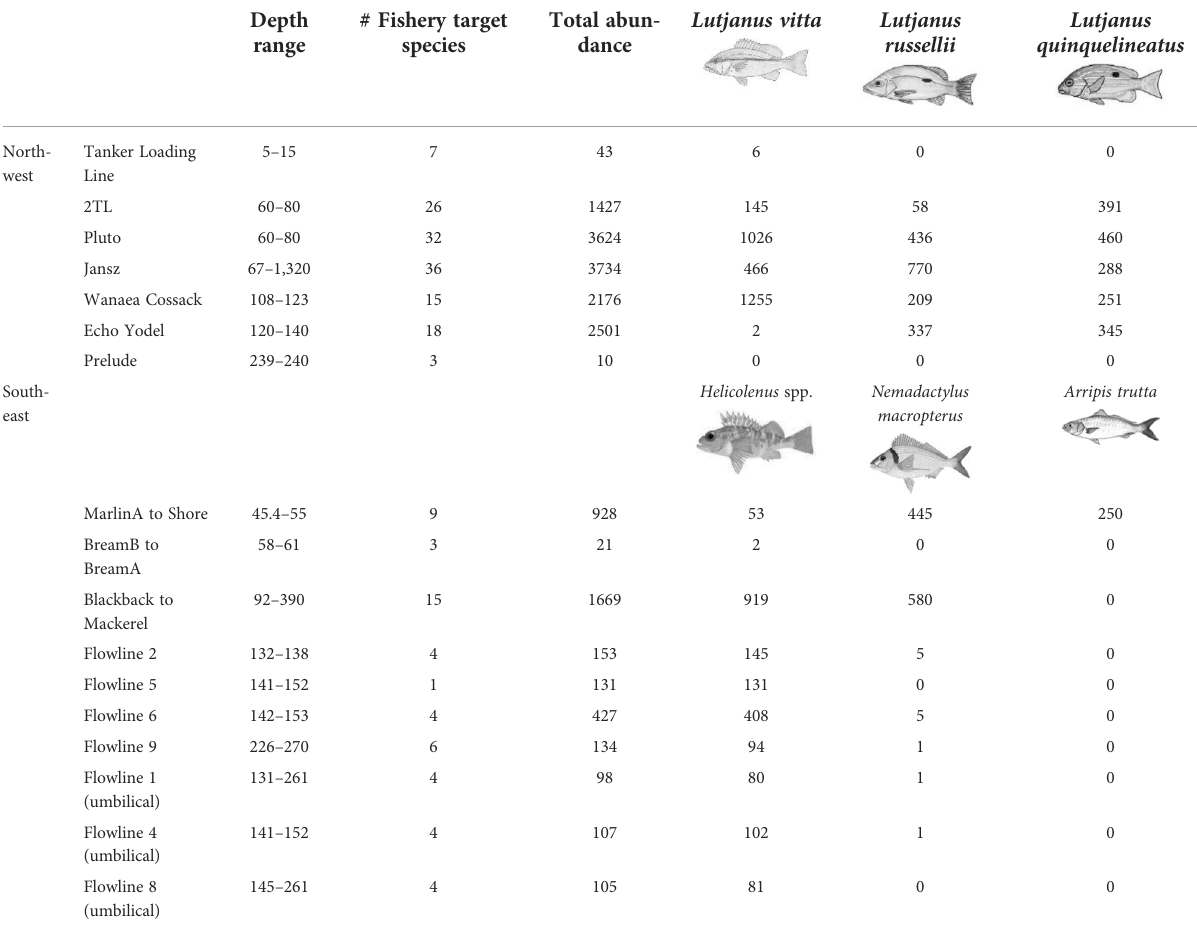
TABLE 6 Abundance of all fi shery target species on remotely operated vehicle imagery of subsea pipelines. Ordered by region then approximately by